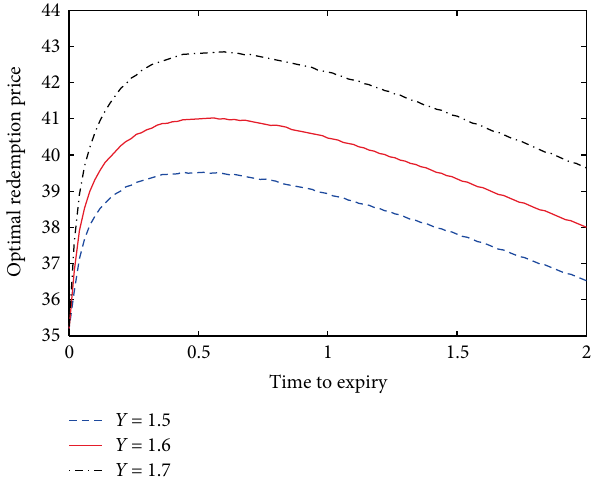
Figure 12: Optimal redemption prices with 𝐶 = 0.03, 𝐺 = 1.2, 𝑀 = 3, 𝑇 = 2, 𝐾 = 50